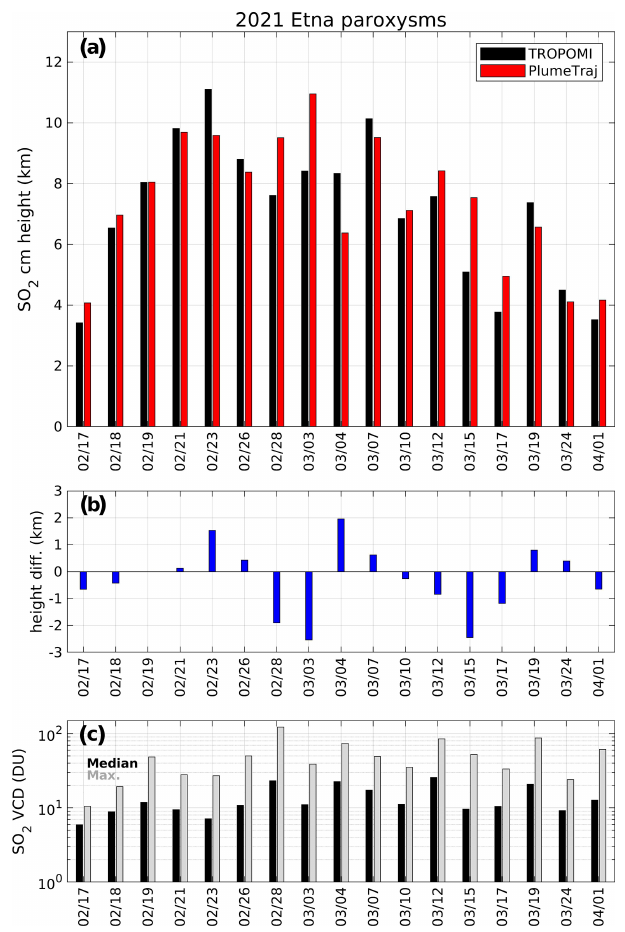
Figure 7. (a) Comparison of SO 2 center of mass height (km) from TROPOMI and PlumeTraj for 17 Etna paroxysmal events in 2021. (b) Differences of TROPOMI minus PlumeTraj SO 2 height (root mean square error: 1.25km). (c) Median and maximum SO 2 columns retrieved by TROPOMI